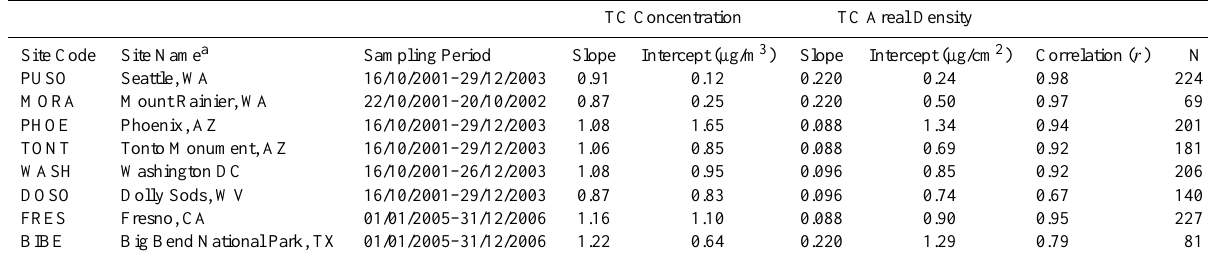
Table 5. Robust regression statistics of uncorrected STN/CSN TC against IMPROVE TC for data from the eight collocated sites.